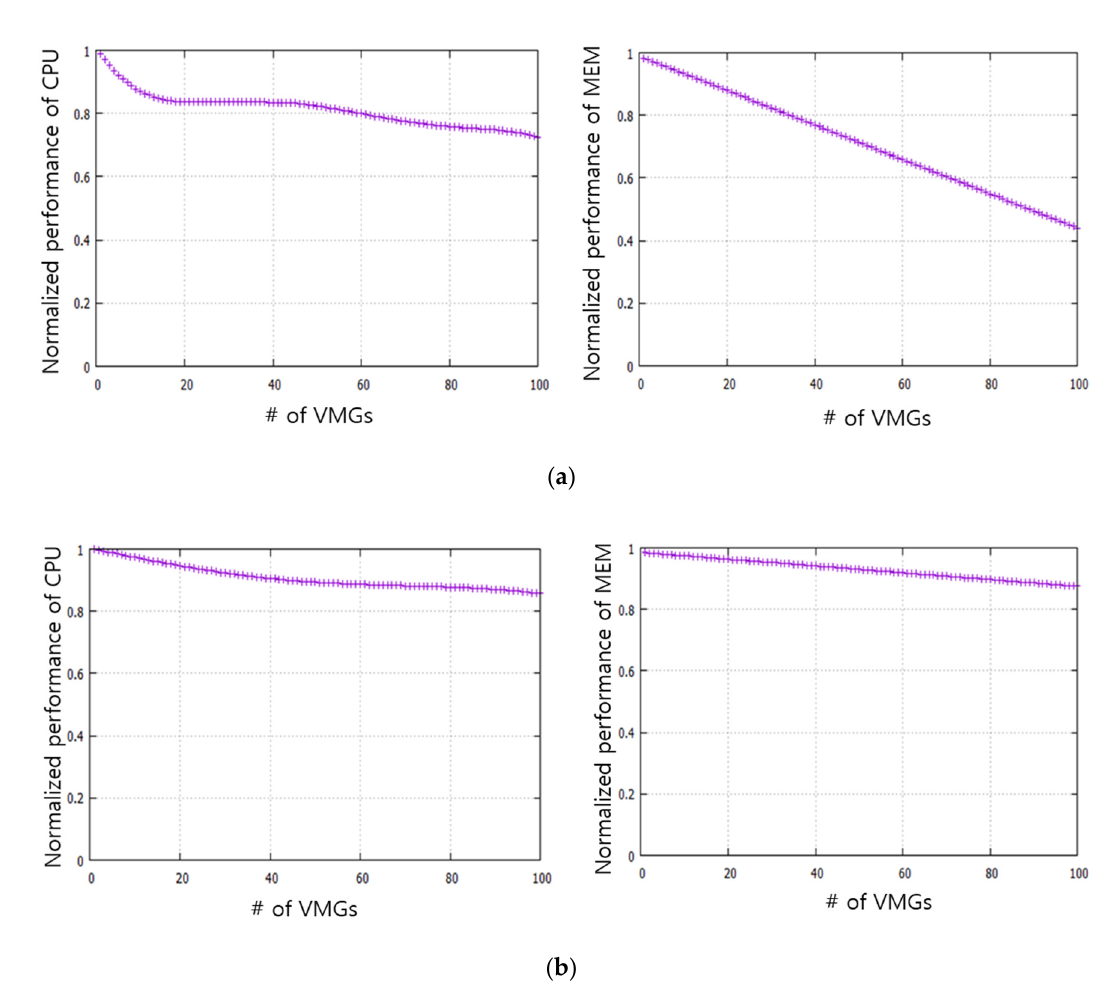
Figure 8. Performance of CPU and memory with an increasing number of VMGs: ( a ) Performance of PVS 1 with an increasing number of Windows VMGs; ( b ) Performance of PVS 2 with an increasing number of Linux VMGs.